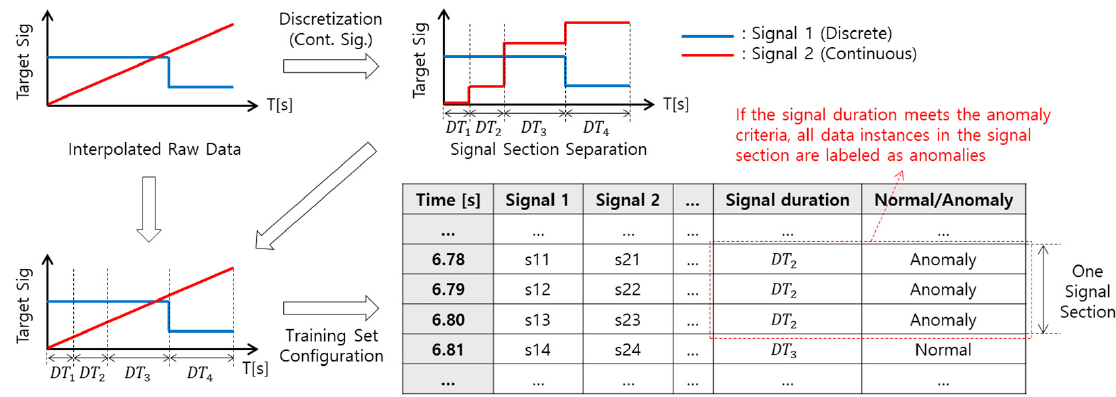
Table 8. Hyper parameter settings for the one-class SVM-based anomaly detection models.